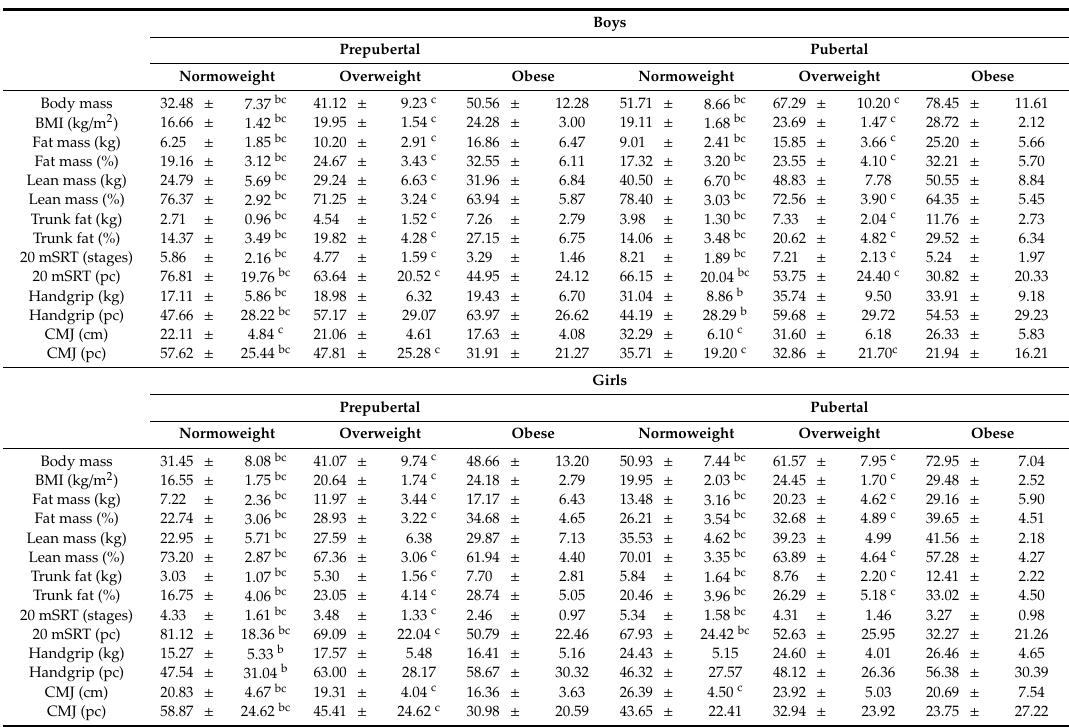
Table 1. Di ff erences in body composition, physical fitness parameters and KIDMED scores among weight status